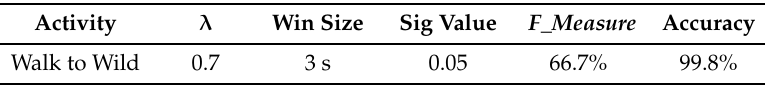
Table 3. Optimized parameter set with GA for walk to wild on real